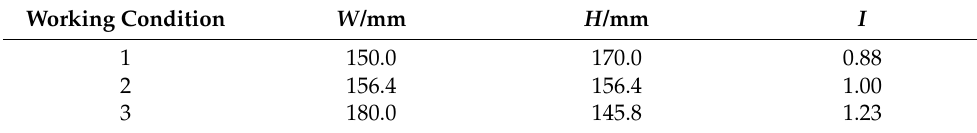
Table 2. Aspect ratio of the device.